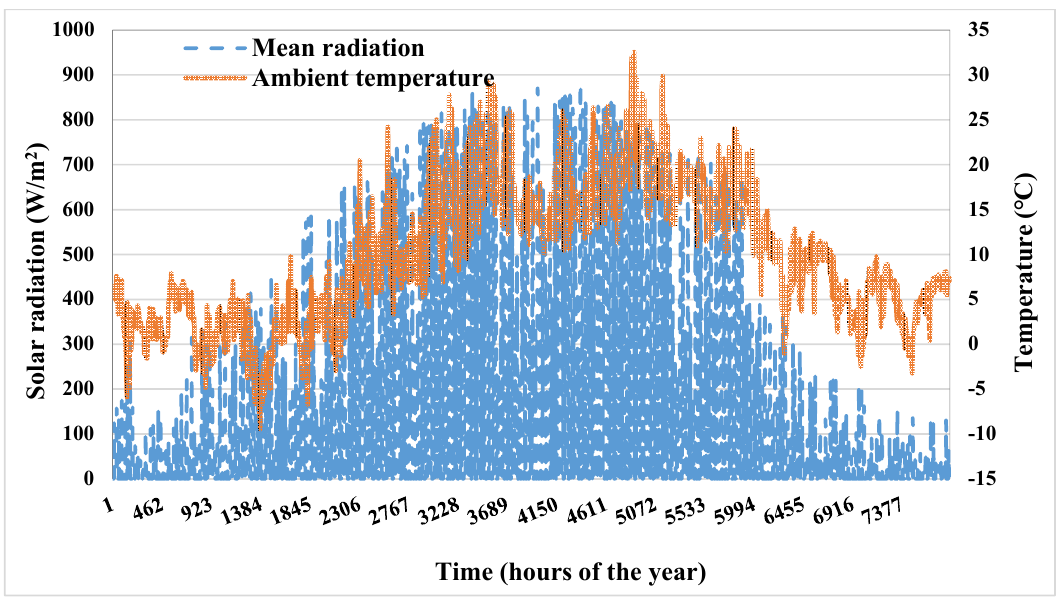
Figure 6. Hourly averaged ambient temperature and solar irradiation in Esbjerg throughout 2018.